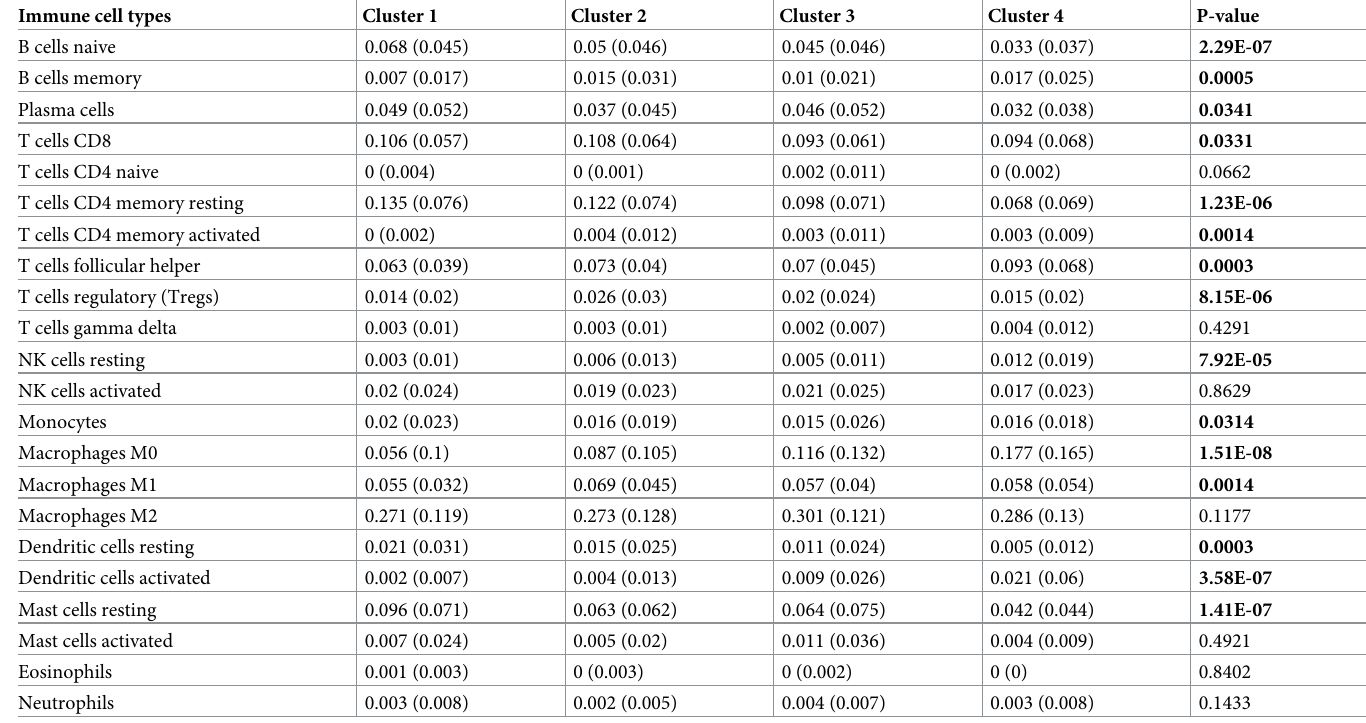
Table 4. Comparison of 22 CIBERSORT immune cell types among the four clusters identified in TCGA, showing mean (standard deviation) values. Immune cell